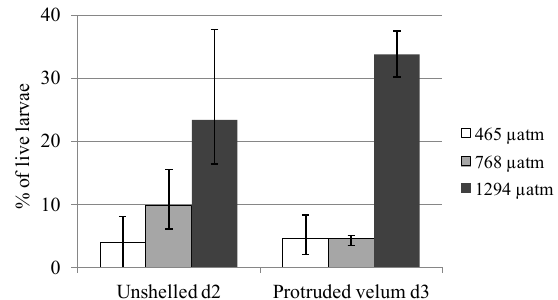
Figure 2. Mean survival (%) based on the number of incubated eggs, and standard deviation ( n = 4) for larvae at three p CO 2 levels – 465 (ambient), 768 and 1294µatm – at days 3, 7 and 14 post- spawn.